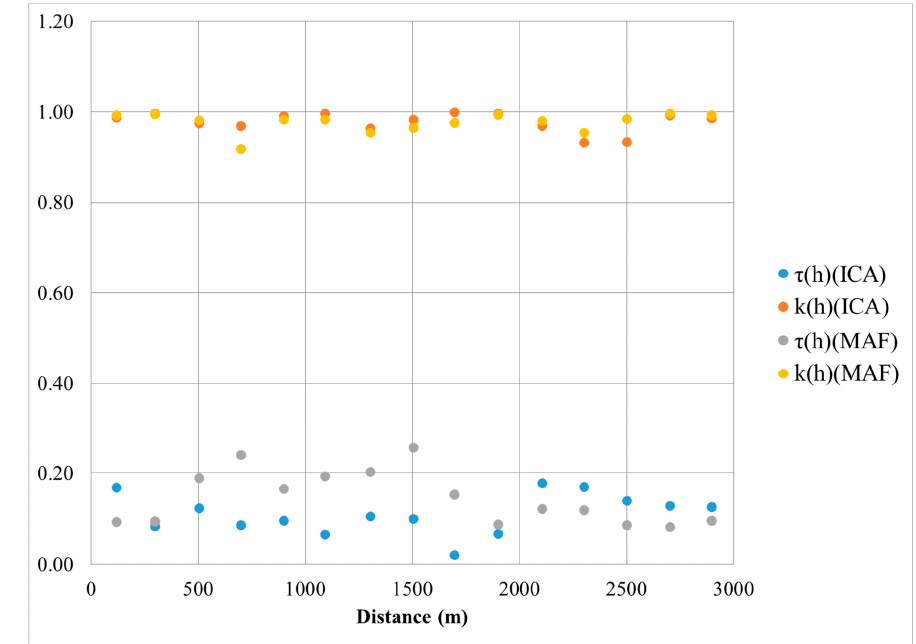
The same exponential covariance function was fitted (blue solid line) to both the original experimental variogram (red dots) and the back-transformed simulated realizations (black solid lines). ISPRS Int. J. Geo-Inf. 2020 , 9 , x FOR PEER REVIEW